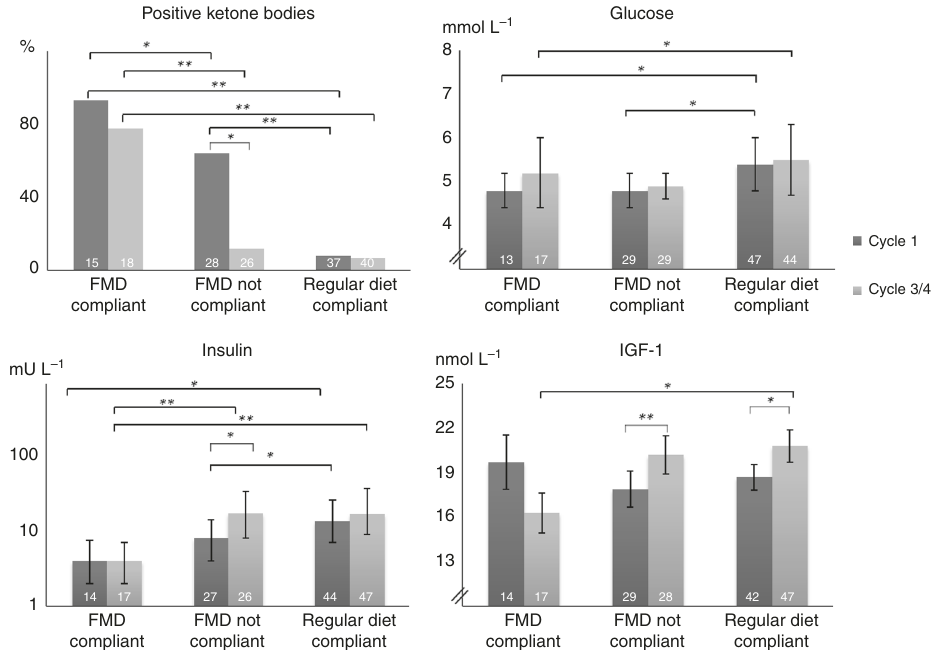
Fig. 5 Metabolic and endocrine parameters before chemotherapy compared between compliant and non-compliant patients halfway therapy of the FMD group and the regular group. Values are measured on day − 1 or day 0 before cycle 1 and halfway therapy. * P -value <0.05, ** P- value <0.001 (2- sided). Error bars indicate the standard error of the mean (if data was normally distributed) or the 25% and 75% percentiles of the median (if data was non-normally distributed). Independent t -tests and Mann-Whitney tests were used. Reference values: glucose 3.1 – 6.4 mmol/L; insulin 0 – 20 mU/L; IGF-1